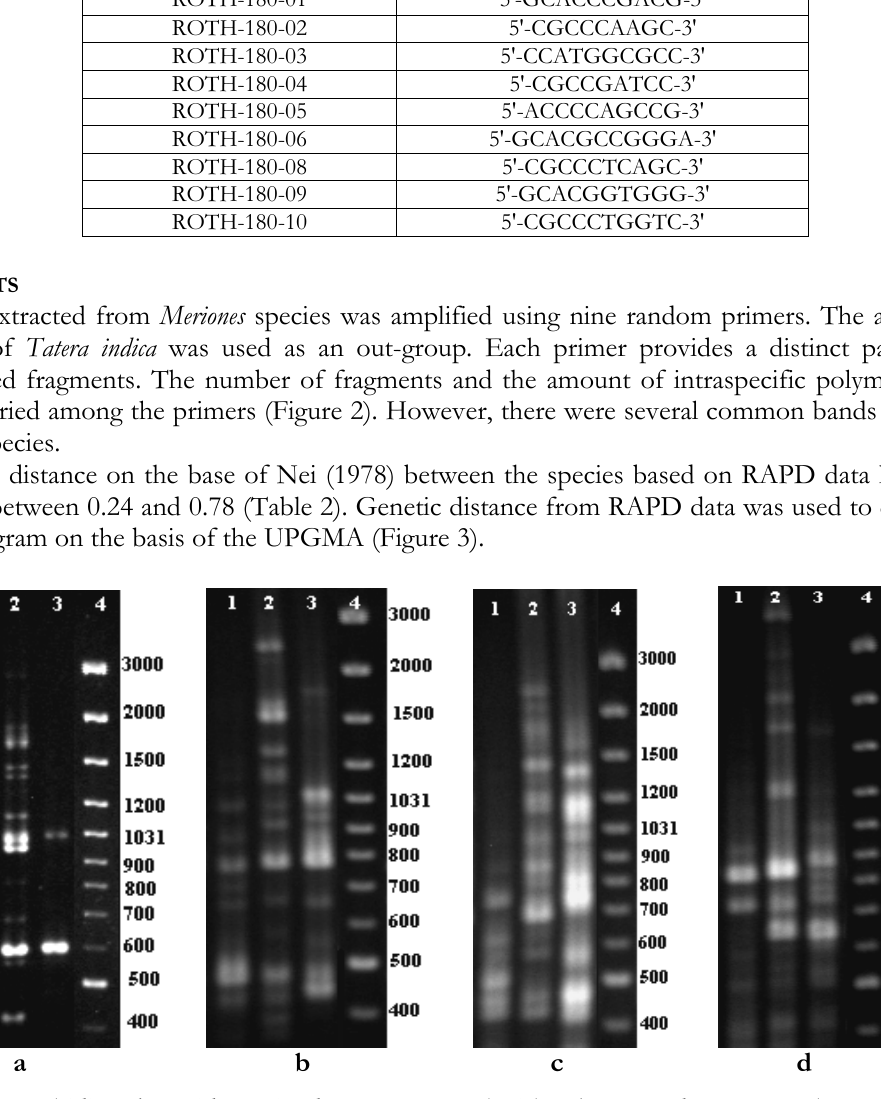
F IG .2.- Ethidium bromide- stained 2% agarose gel with RAPD products (a- Roth-180-02, b- Roth-180-04, c- Roth-180-05, d-Roth-180-06. 1-M. crassus, 2- M. persicus, 3- M. libycus, 4-Gene ruler 100bp DNA